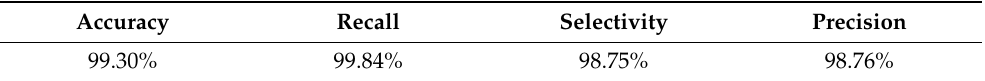
Table 3. The network parameters computed for the numerical